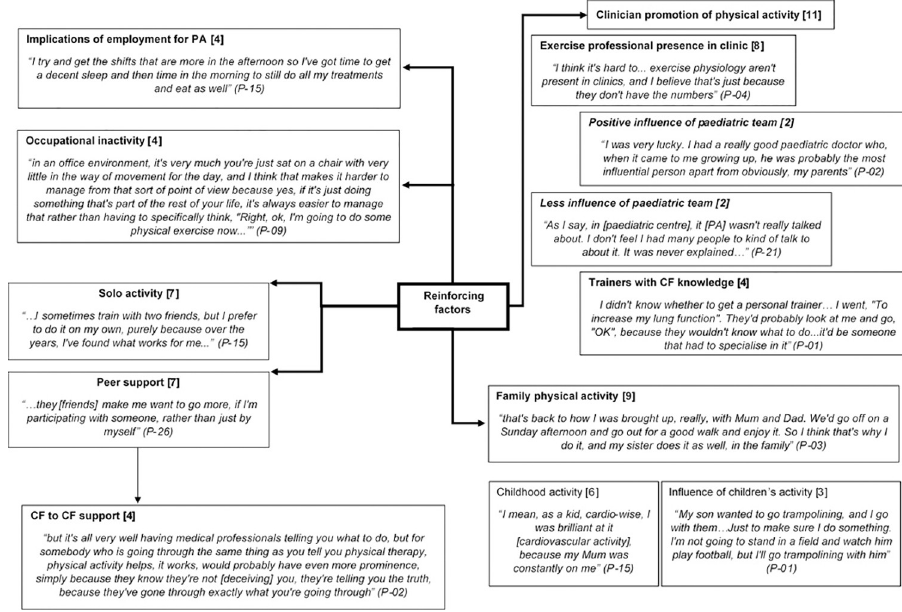
Fig 5. Pen profile displaying reinforcing factors (n = 11) with illustrative quotes, associated participant number and frequency count provided in square